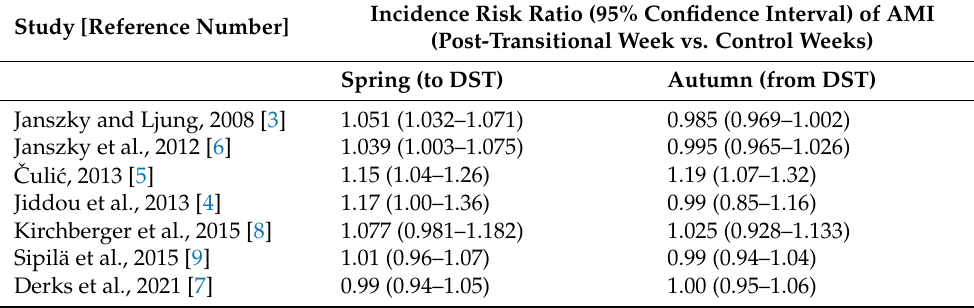
Table 1. Results of the individual studies investigating the risk of AMI after the DST transitions. Incidence Risk Ratio (95% Confidence Interval) of AMI Study [Reference Number] (Post-Transitional Week vs. Control Weeks) Spring (to